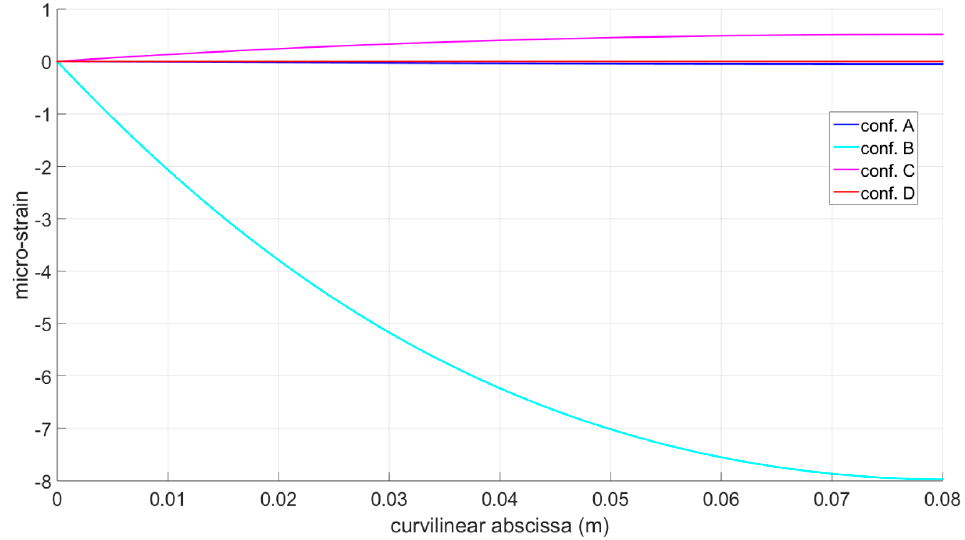
Figure 6. Curvature distribution at the conditions A, B, C, and D of the process of Figure 4, in small and large displacement assumptions.